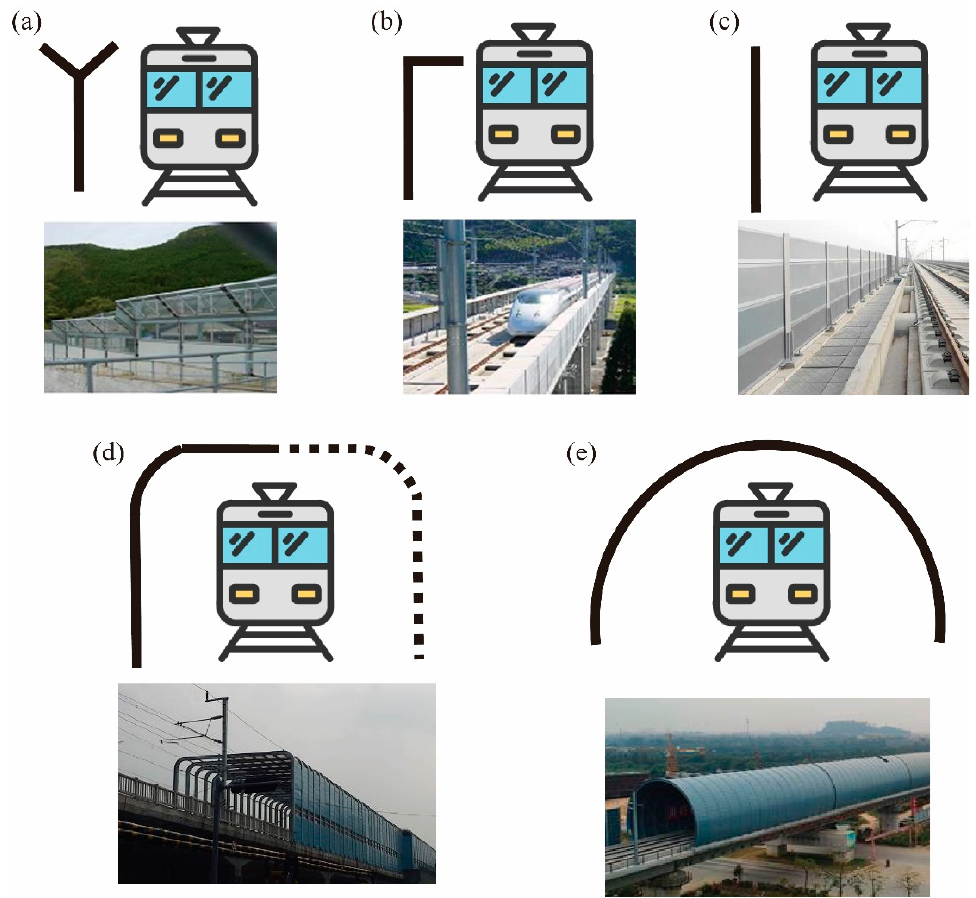
Figure 6. ( a ) Y-shaped sound barrier; ( b ) inverted L-shaped sound barrier; ( c ) upright type sound barriers; ( d ) semi-enclosed sound barrier; ( e ) fully enclosed sound barrier.